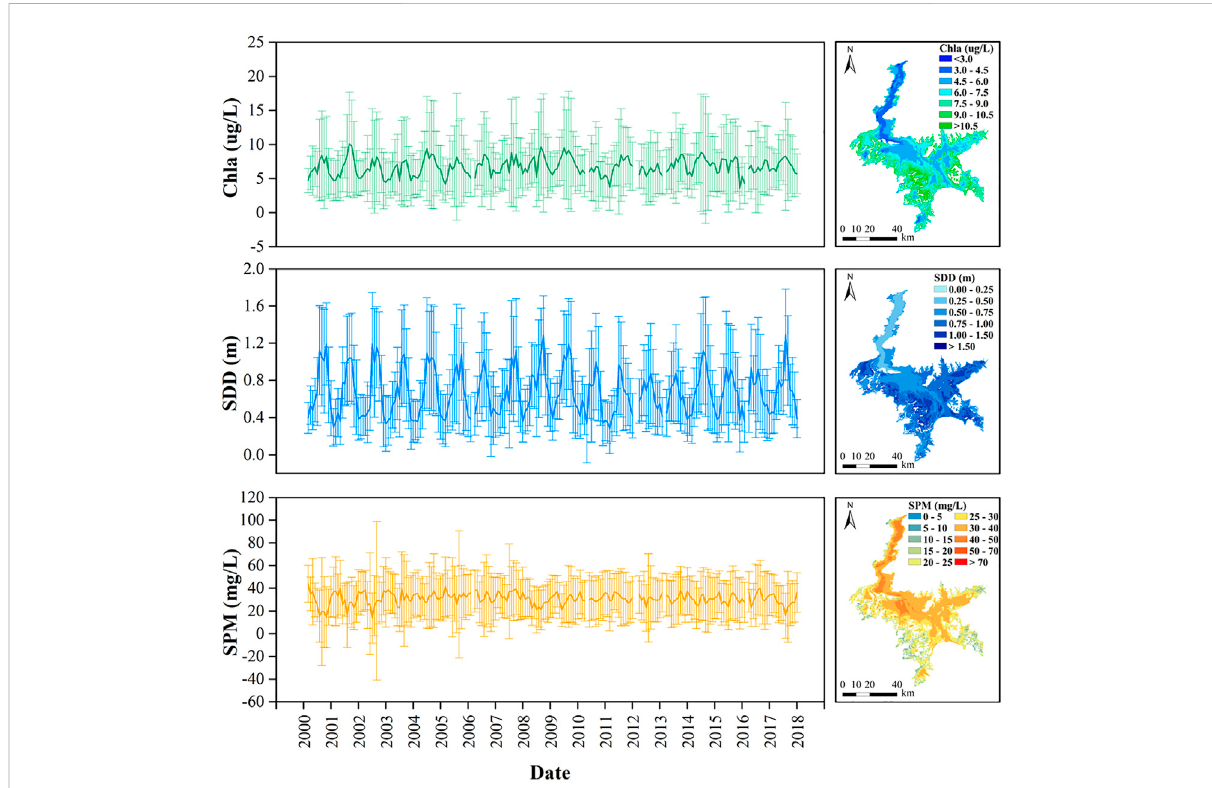
FIGURE 4 Time-series (left panels) and spatial distribution (right panels) of the annual average of Chla, SDD, and SPM estimated from MODIS data for the Poyang Lake. The green line represents the time series of Chla. The blue line represents the time series of SDD. The orange line represents the time series of SPM. Error bars represent the uncertainty of remote sensing inversion